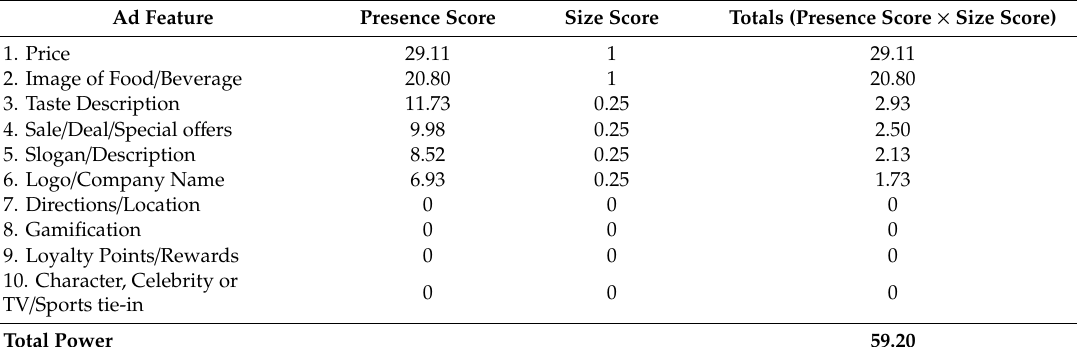
Figure 6. Advertisement C. Table 7. Coding example using the teen-developed tool: Advertisement C.